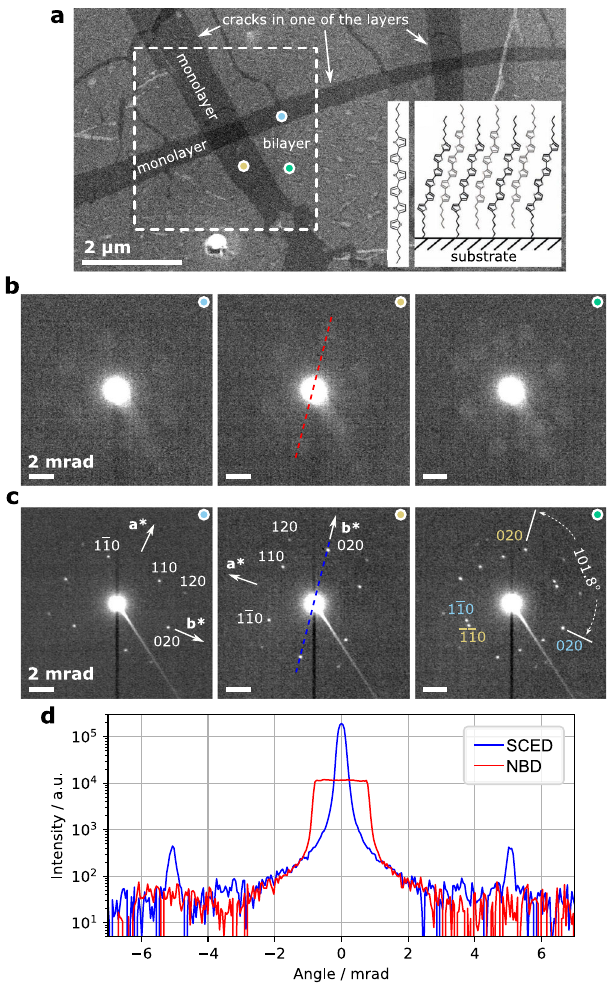
Fig. 2 Comparison of NBD and SCED results of a 2D single crystal thin fi lm of α , ω -DH6T bilayer. a STEM-ADF image of the area of interest (acquired at the end of experiment). Insets show the molecular structure and scheme of the assembled monolayer on the substrate. The white box indicates where 4D-NBD and 4D-SCED data were acquired subsequently. Three representative raw patterns extracted from the positions marked with color dots are shown in b for the NBD results and c SCED results. d intensity pro fi les of the raw pattern comparing NBD and